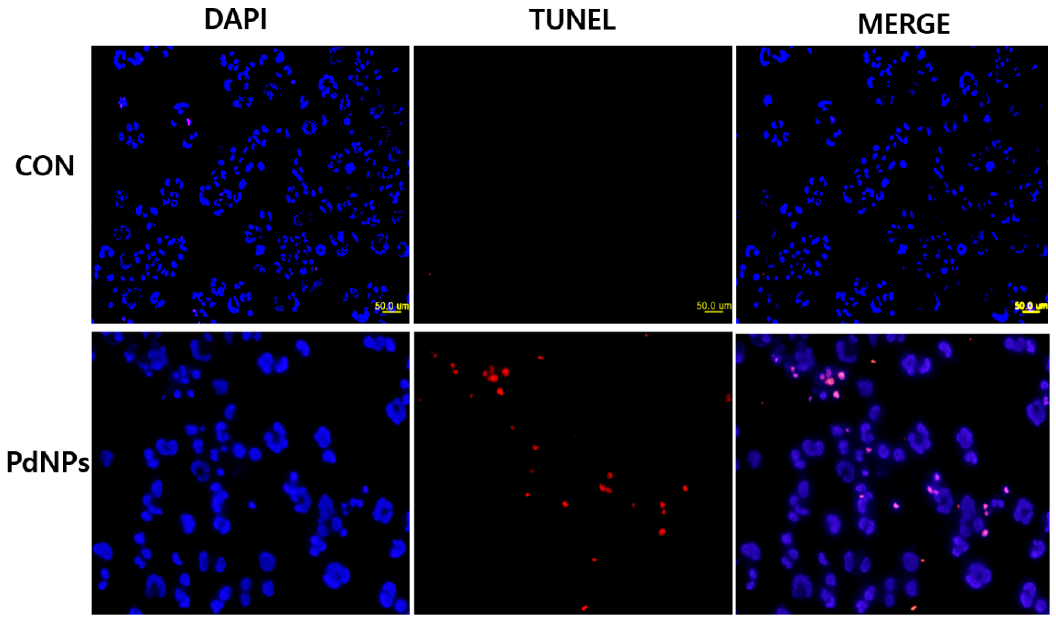
Figure 13. Palladium nanoparticles (PdNPs) induce apoptosis of human ovarian cancer cells. Human ovarian cancer cells were treated with 10 μ g/mL PdNPs for 24 h and apoptosis was assessed using terminal deoxynucleotidyl transferase dUTP nick end labeling (TUNEL) assay. Nuclei were counterstained with 4 ′ ,6-diamidino-2-phenylindole (DAPI). Representative images show apoptotic (fragmented), DNA (red staining), and corresponding nuclei (blue staining) (Scale bar-50 μ m).